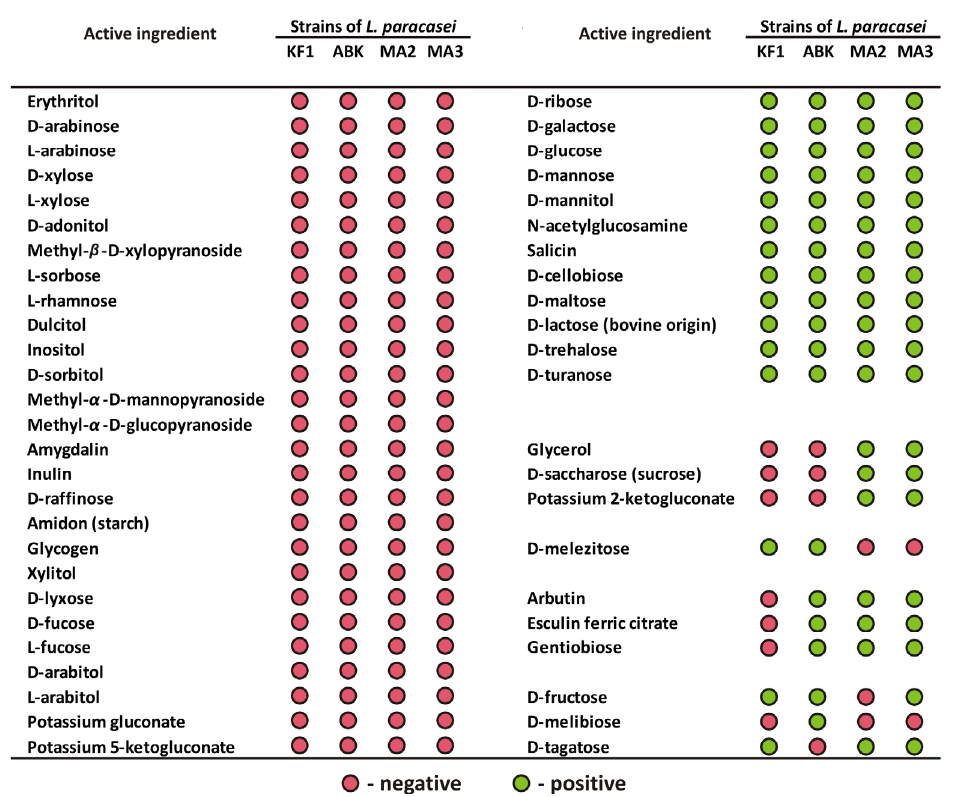
Figure 2. The API 50 substrate utilization profile of the kefir-derived (KF1 and ABK) and mahewu- derived (MA1 and MA2) strains of L. paracasei . The data for the kefir-derived strains were obtained from Begunova et al. [31].